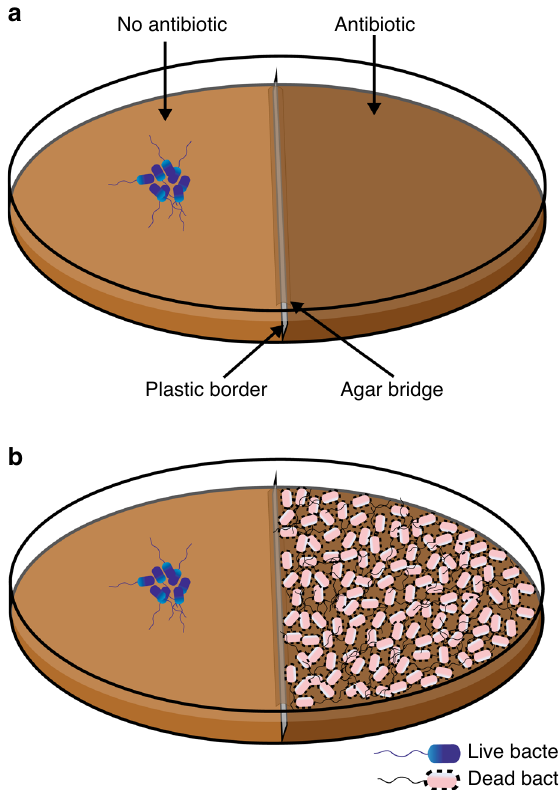
Fig. 2 Border-crossing assay. a Petri plates with a plastic divider create two chambers. The left chamber is poured with media without antibiotic, and the right chamber with antibiotic. After the media is set, the two chambers are connected by a thin layer of agar on the top of the bridge 12 . Bacteria are inoculated in the left chamber as indicated, and allowed to swarm to the right chamber. b As in ( a ), but with dead bacteria layered on the surface of media on right.